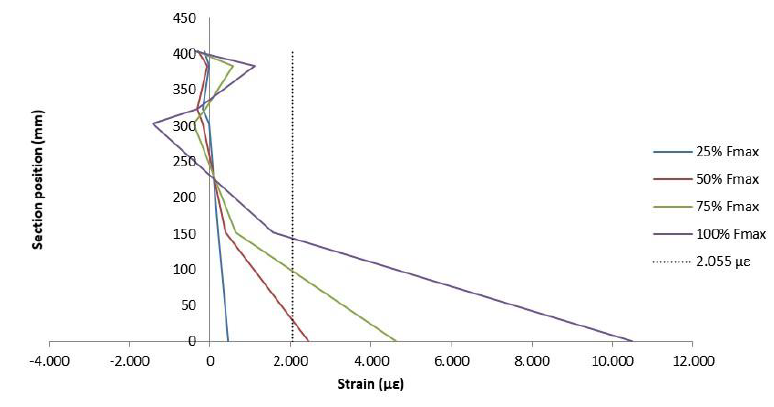
Figure 22. Strain distribution curve – V3A.